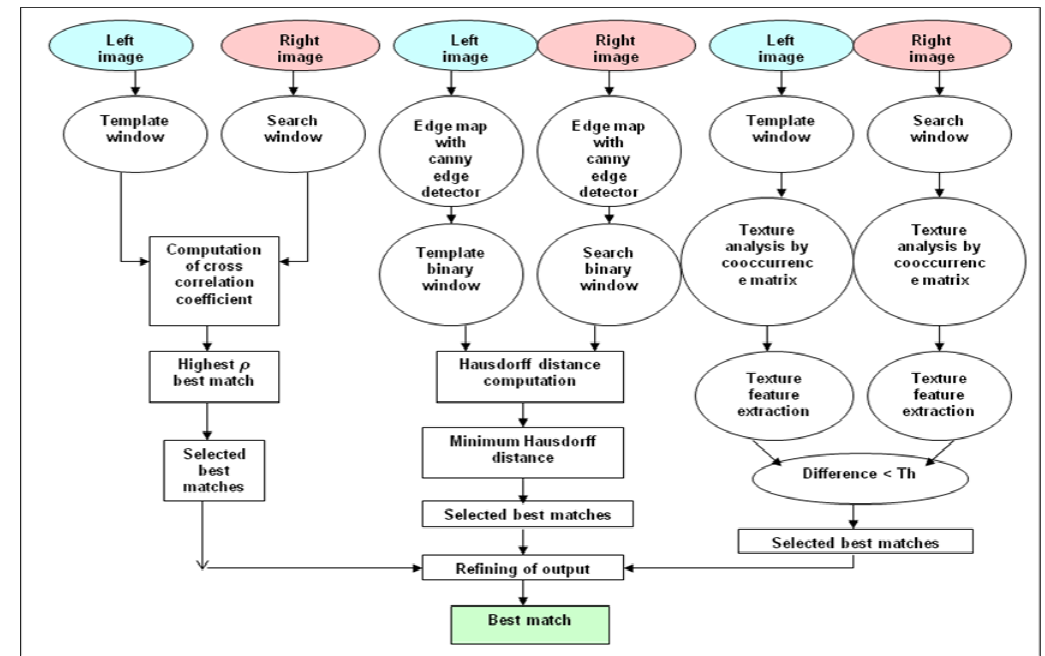
Figure 3 Block diagram for the proposed